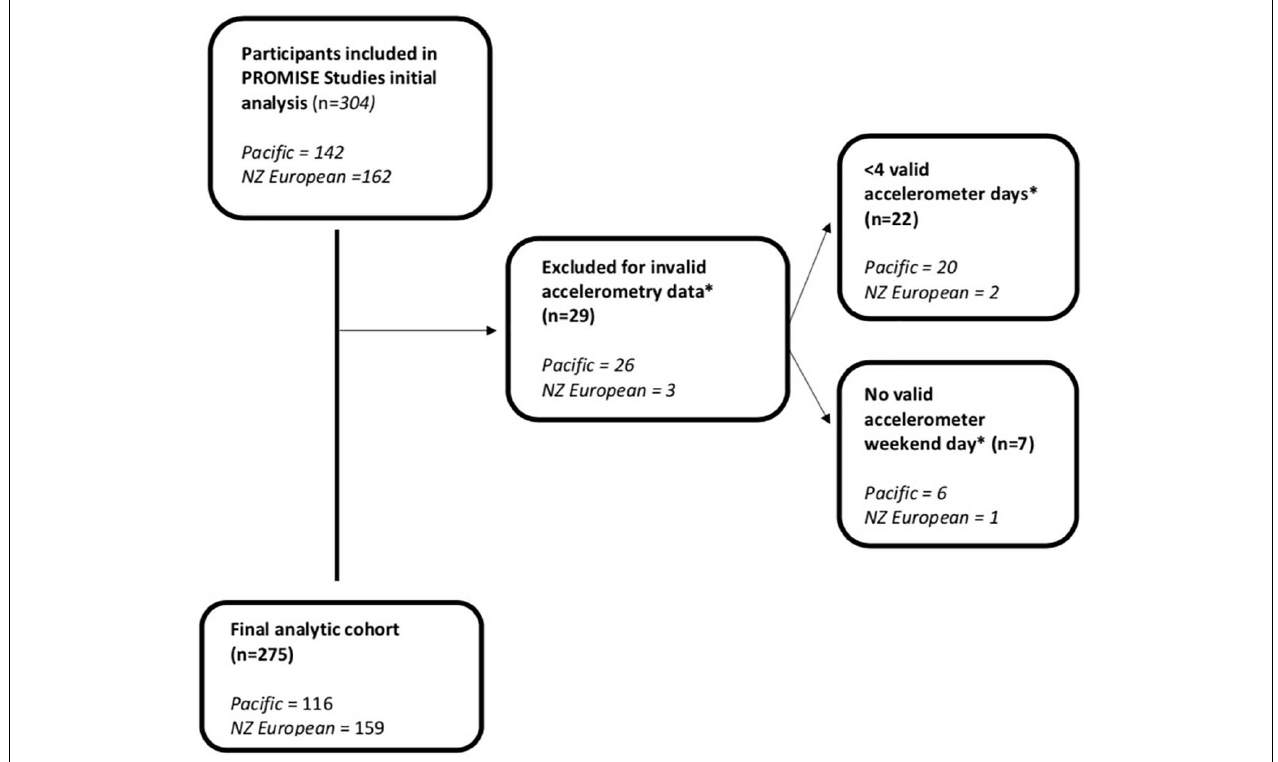
FIGURE 1 | Flowchart of participants included in